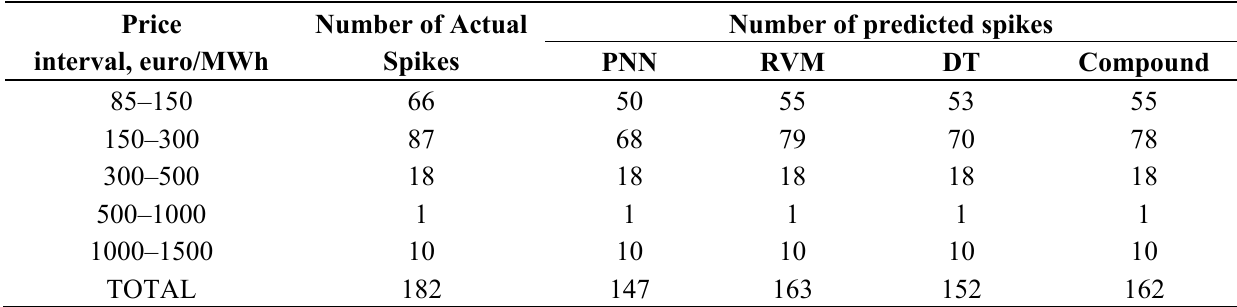
Table 7. Results obtained by the compound classifier for different price spike